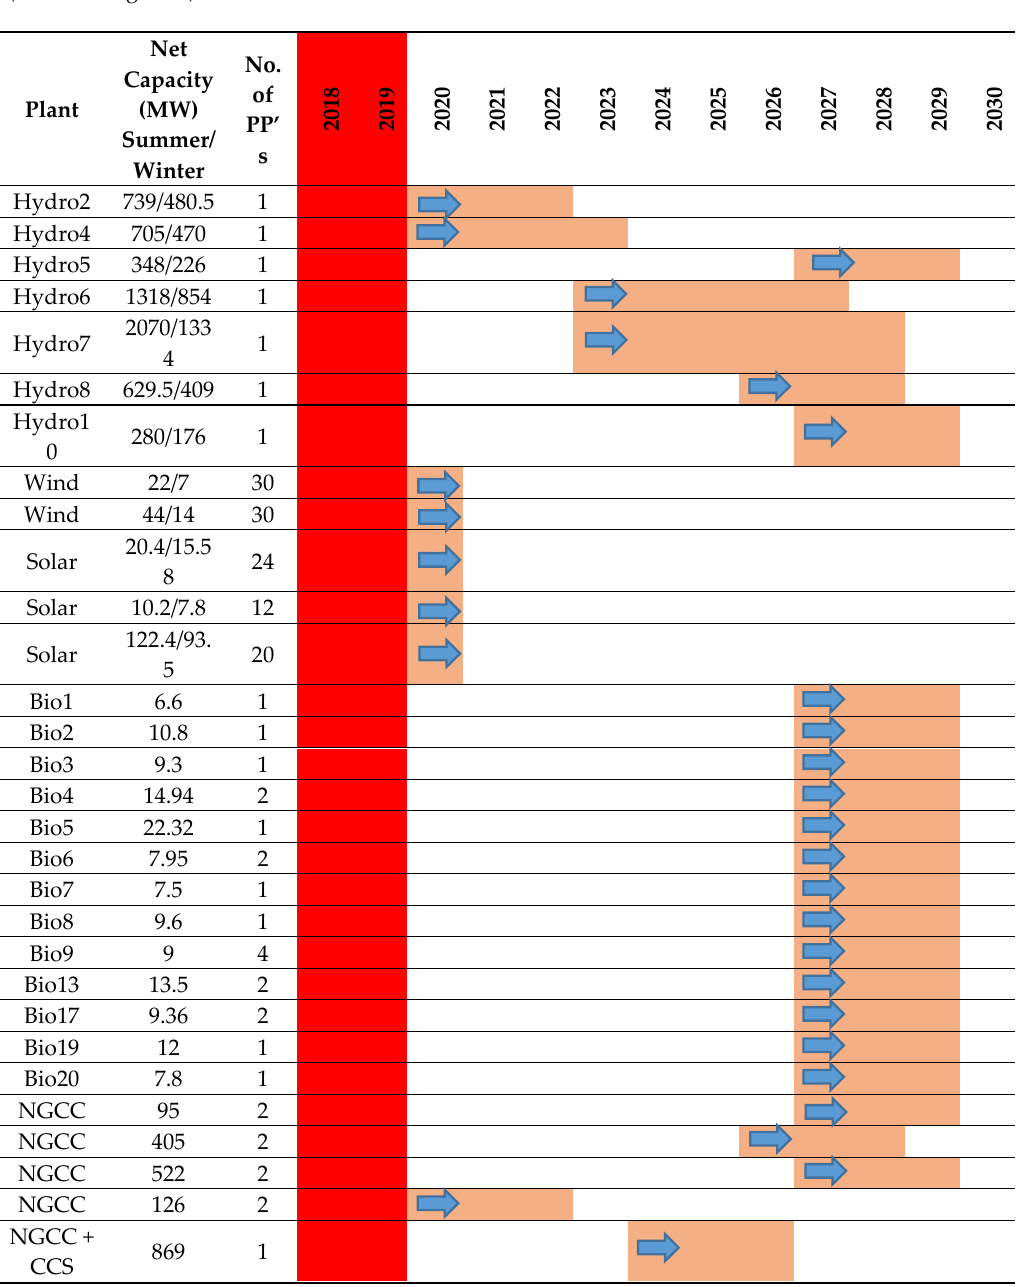
Table A11. Details of the Plants Installation under Capacity Expansion: Normal GDP CCS on New